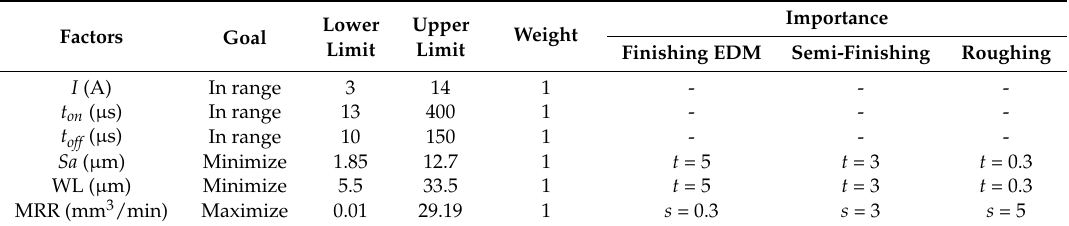
Table 9. The goals and factor range for optimization.